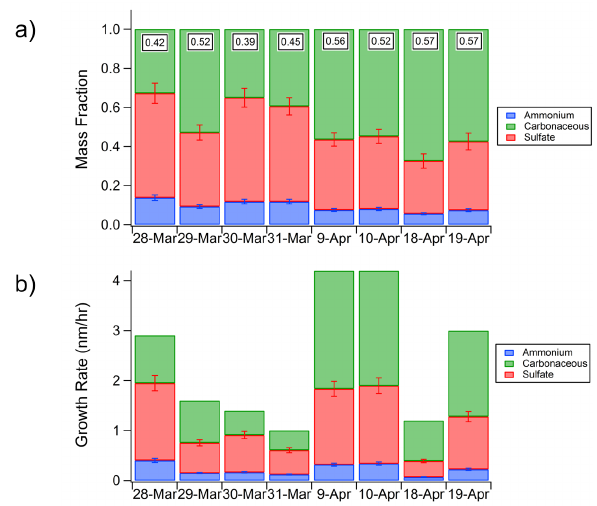
Fig. 3. (a) Mass fractions of sulfate, ammonium and carbonaceous matter for eight NPF events during the measurement campaign. The numerical value inset in each bar is the O/C ratio for that event pe- riod. (b) Mass growth rates of sulfate, ammonium and carbonaceous matter for the same NPF events. Molecular composition uncertain- ties are based on assigned uncertainties for measurement of elemen- tal nitrogen and sulfur